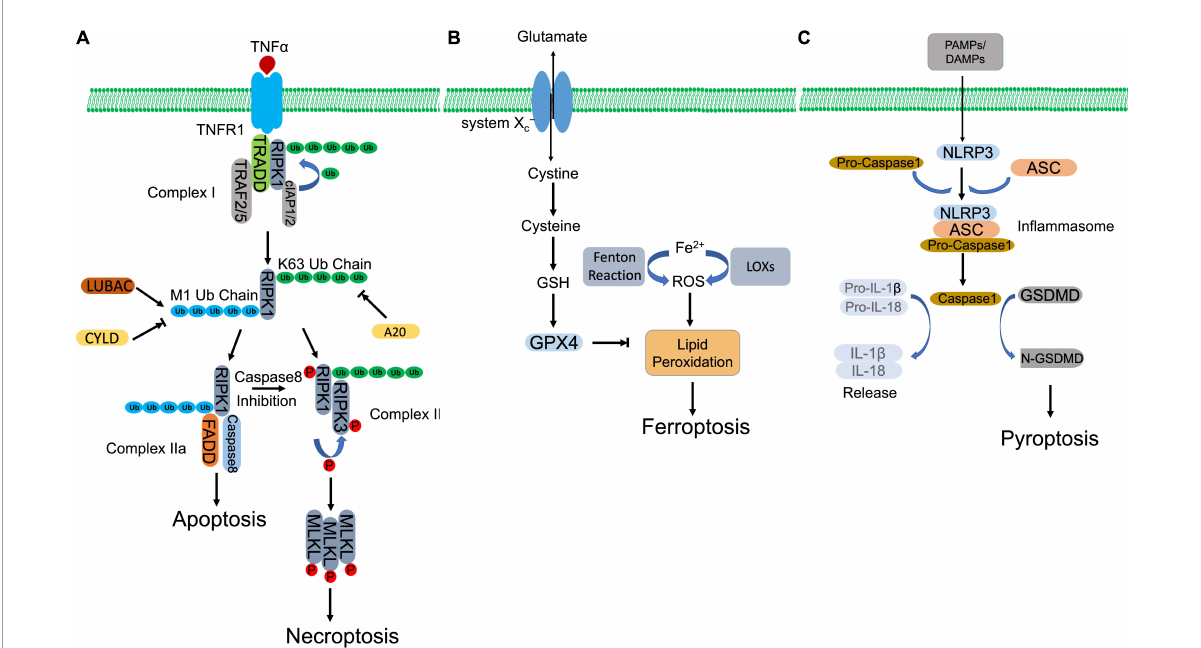
FIGURE1 Molecular mechanisms of regulated necrosis. (A) Necroptosis. Activation of TNFR1 by TNF α induces the formation of complex I, which contains RIPK1, TRADD, TRAF2/5, and cIAP1/2. Then, RIPK1 is ubiquitinated by cIAP1/2 to form K63-ubiquitin chains, which is removed by A20. The formed K63 uboquitination recruits LUBAC to complex I, where LUBAC catalyzes the formation of M1-ubiquitin chain on RIPK1, which is removed by CYLD. K63 ubiquitination of RIPK1 promotes the formation of necrosome, which subsequently phosphorylates MLKL to initiate necroptosis. Whereas, M1 ubiquitination induces the assembly of complex IIa, which initiates apoptosis. When caspase 8 is inhibited, necroptosis is triggered via activation of necrosome. (B) Ferroptosis. Aberrant buildup of ROS induces lipid peroxidation, which leads to ferroptosis. Intracellular ferrous ion (Fe 2 + ) catalyzes lipid peroxidation via Fenton reaction and LOXs. GPX4, in turn, hydrolyses lipid peroxides, converting them to corresponding lipid alcohols. The antioxidant activity of GPX4 requires the participation of GSH, whose synthesis depends on cystine/glutamate antiporter system X c - . inhibition of GPX4 or system X c - initiates ferroptosis. (C) Pyroptosis. PAMPs and DAMPs activate inflammasome assembly. Inflammaspme sensor (NLRP3) interacts with ASC, which recruits pro-caspase 1. Pro-caspase 1 is activated by autocleavage. Activated casapse 1 not only cleaves GSDMD to induce pyroptosis, but also processes the precursors of IL-1 β /IL-18 to mature IL-1 β /IL-18, which are released through the pores formed by